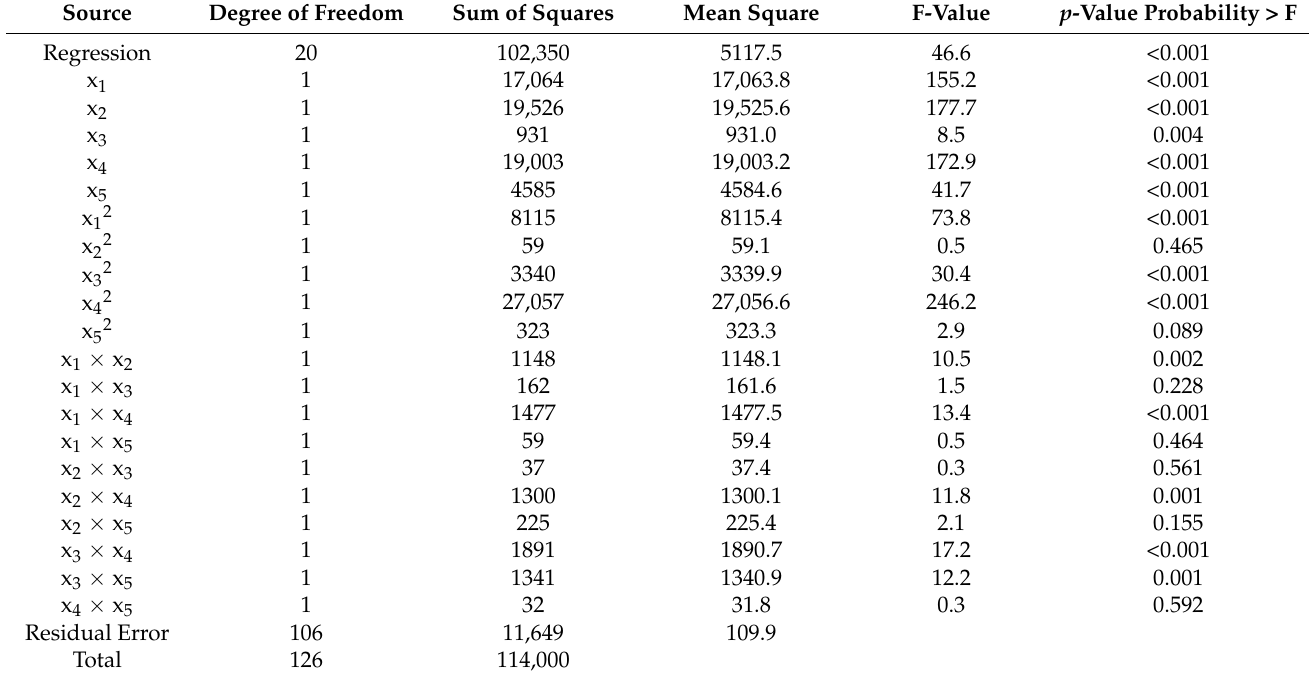
Table 5. Analysis of variance for RB5